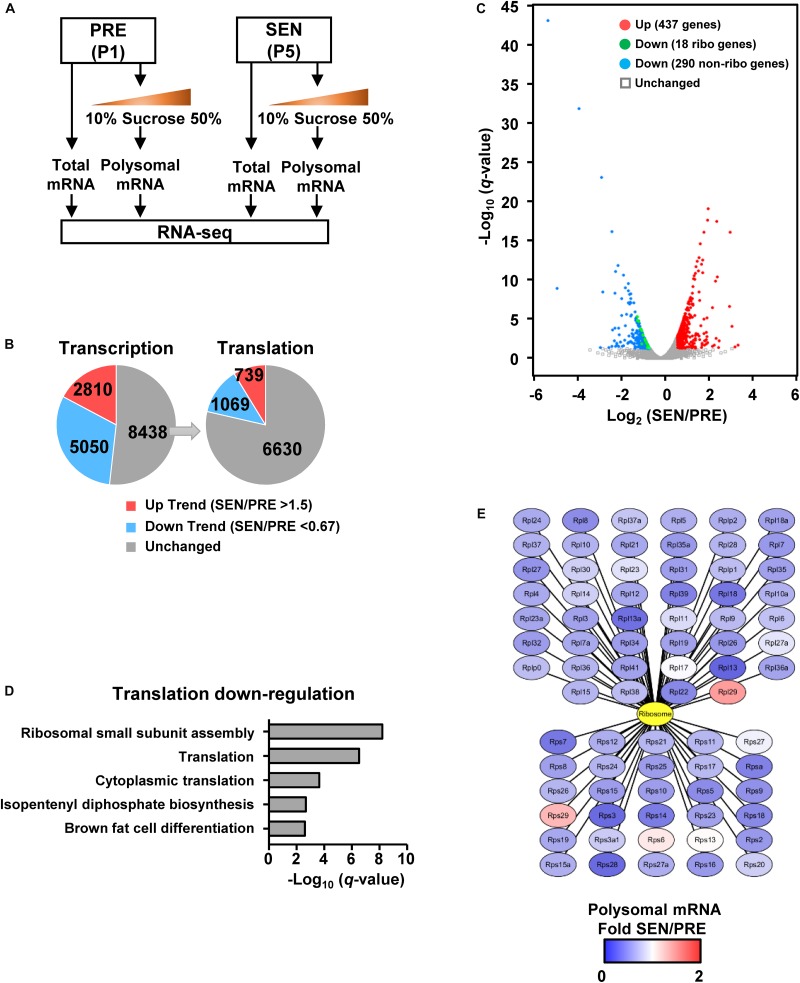
Polysomal RNA-seq reveals that the ribosome biogenesis is deficient in senescent cells. (A) RNA-seq samples are collected using total mRNA extract and polysomal mRNA fraction in young and senescent MEFs. (B) Gene numbers of transcriptional and translational changes were calculated from comparing total and polysomal RNA-seq data. The threshold of fold-changes was set to 1.5 for the trend of up-regulation and 0.667 for the trend of down-regulation. (C) Volcano plot shows significantly regulated genes on translational level. The threshold of significance was set to FPKM SEN/PRE >1.5, FDR q < 0.05 for up-regulation and FPKM SEN/PRE <0.67, FDR q < 0.05 for down-regulation. (D) Biological process analysis of genes which were only down-regulated in translational level shown in panel (C). (E) Translationally changed genes of ribosomal protein calculated from polysomal RNA-seq data. All 46 large subunit ribosomal proteins were illustrated in the upper part, while 30 small subunit ribosomal protein were shown in the lower part.